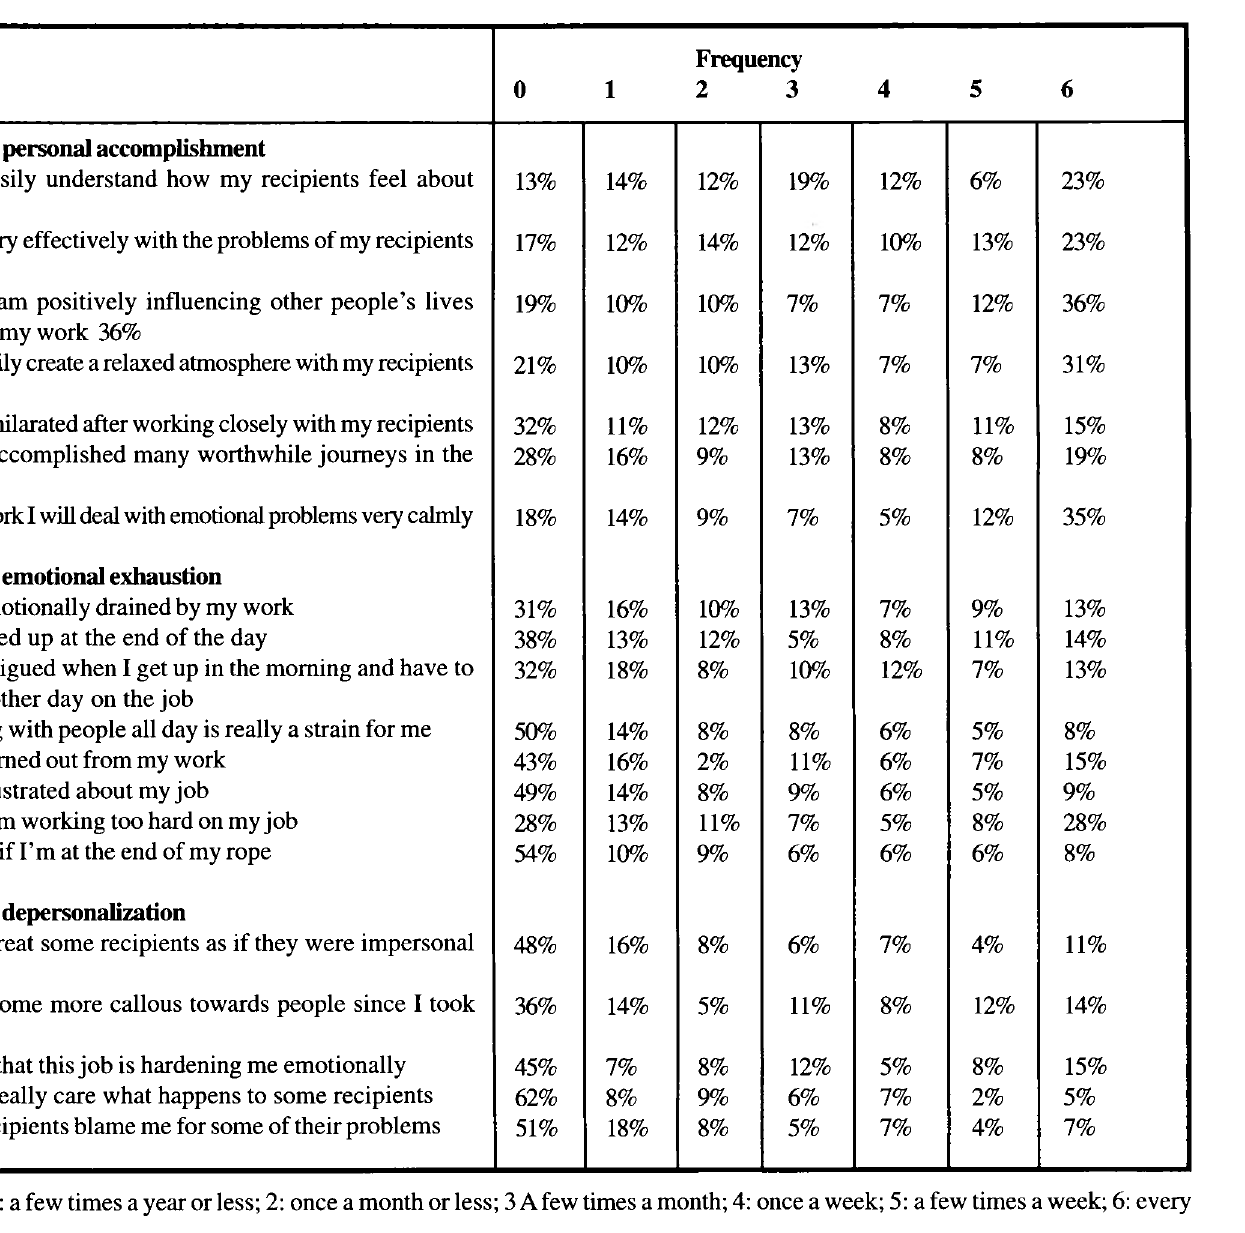
Table 5: Measures of